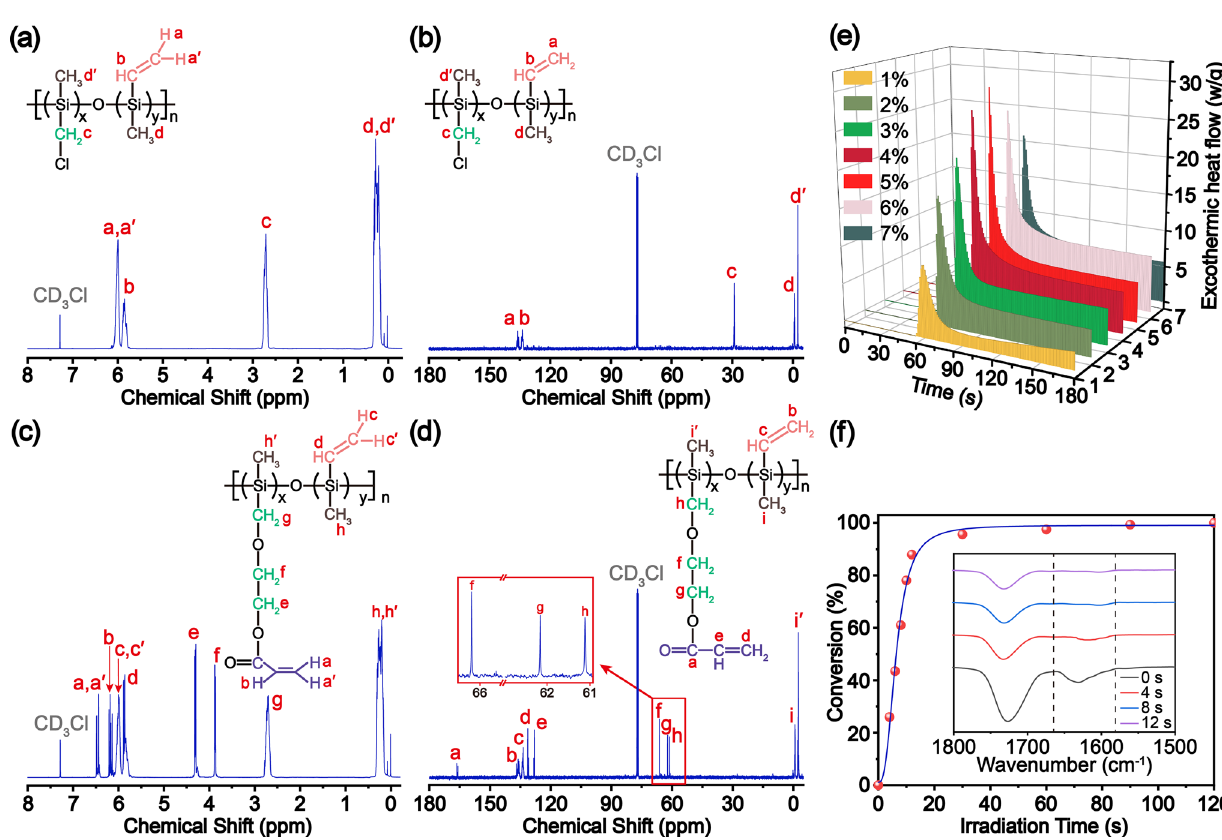
Fig. 2 Structural characterization of the PSO and UV–PSO precursors: a, c 1 H NMR spectra; b, d 13 C NMR spectra; e DPC thermograms of UV–PSO with different photoinitiator concentrations; and f conversion percentage of acrylic group at different curing times (inset with FT-IR